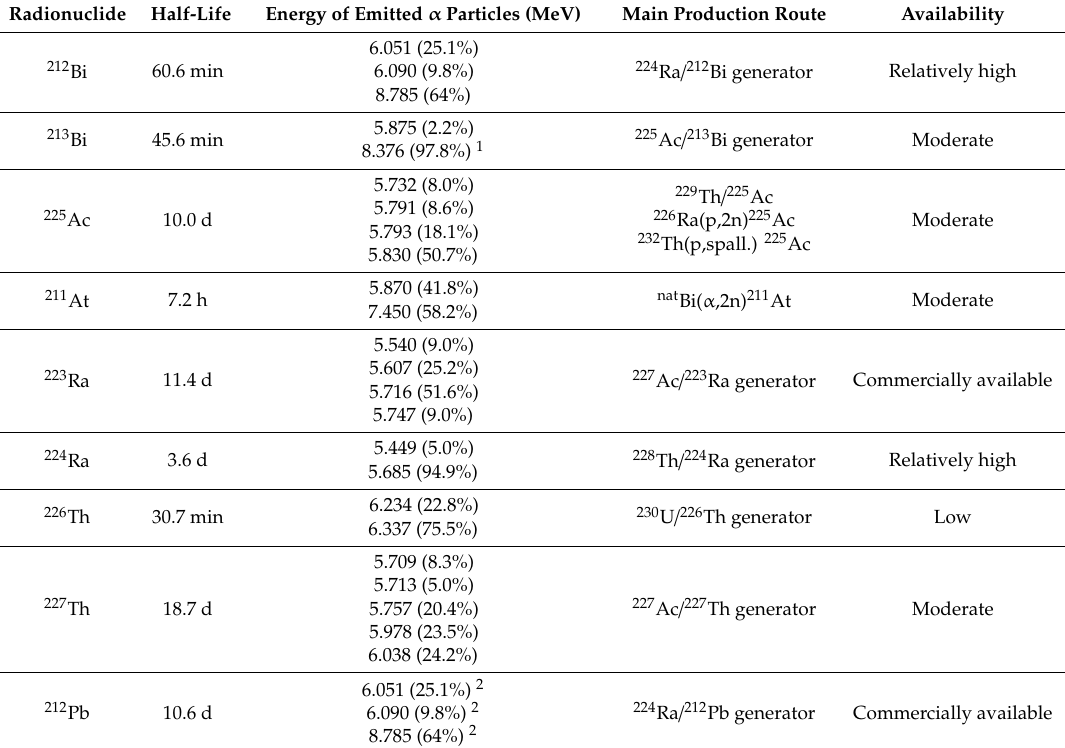
Table 1. Physical properties of α -emitting radionuclides of interest for medical applications. Radionuclide